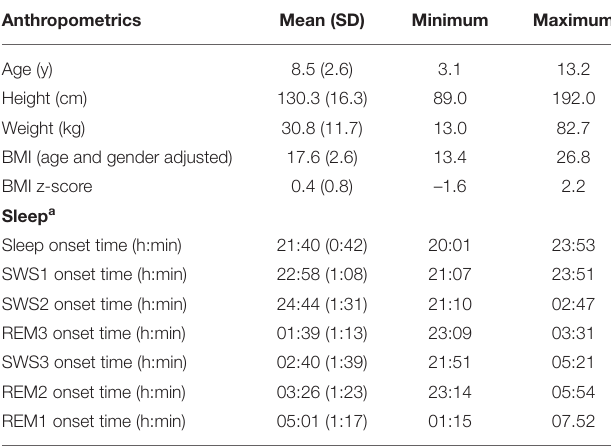
TABLE 1 | Minimum, maximum and mean (SD) anthropometric and sleep values (75 children). Anthropometrics Mean (SD)